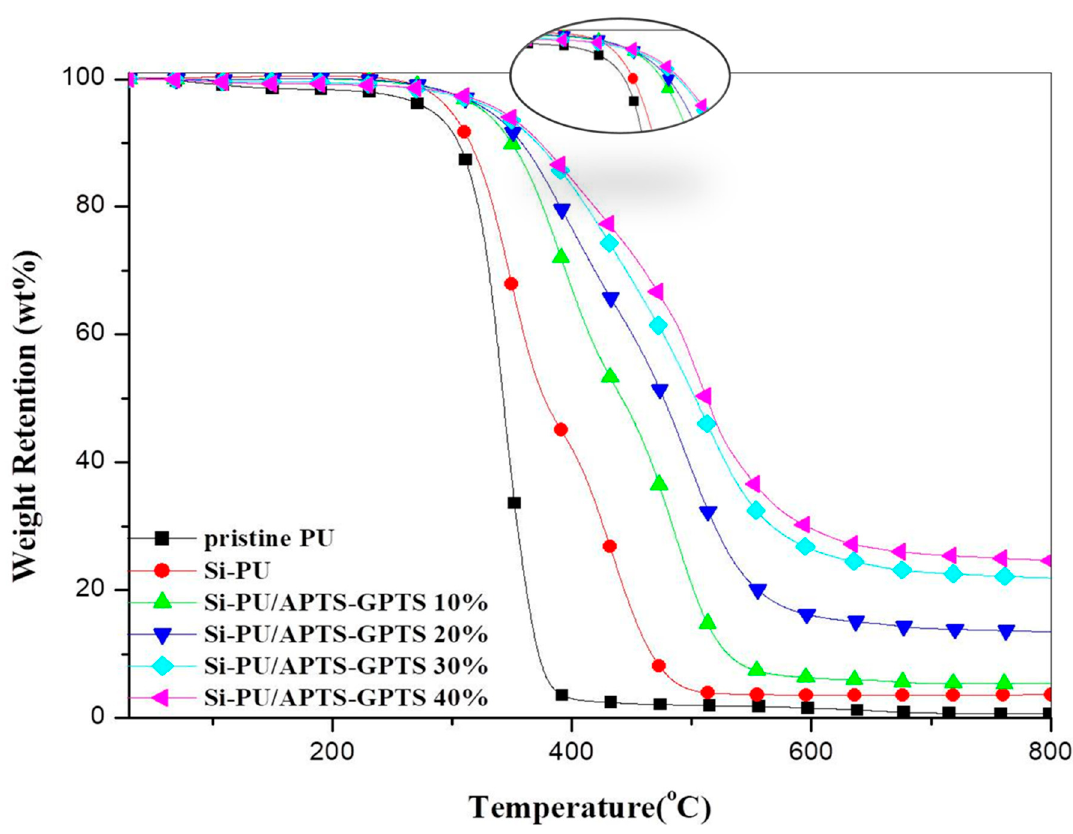
Polymers 2018 , 10 , x FOR PEER REVIEW 12 of 18